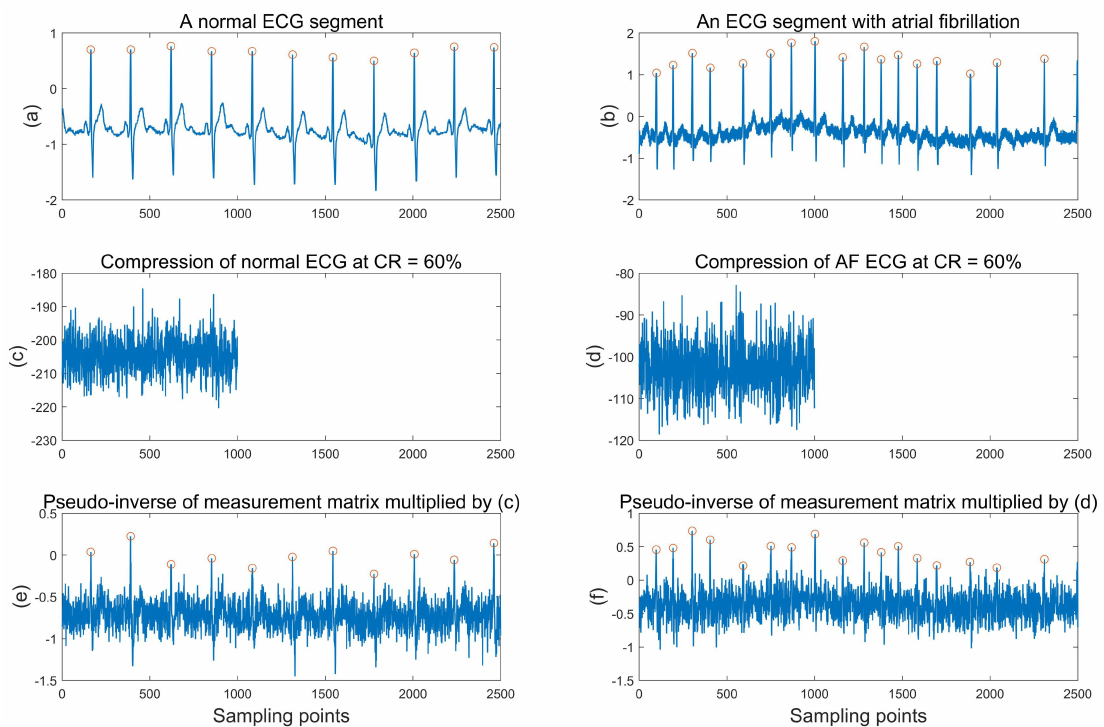
Figure 1. An example of compressed sensing of normal ECG segment and AF ECG segment. ( a ) is a normal ECG segment and ( b ) is an ECG segment with AF; ( c , d ) are the compressed data of ( a , b ), respectively; ( e , f ) are the results of multiplying the pseudo-inverse of the measurement matrix with the compressed normal ECG and AF ECG,